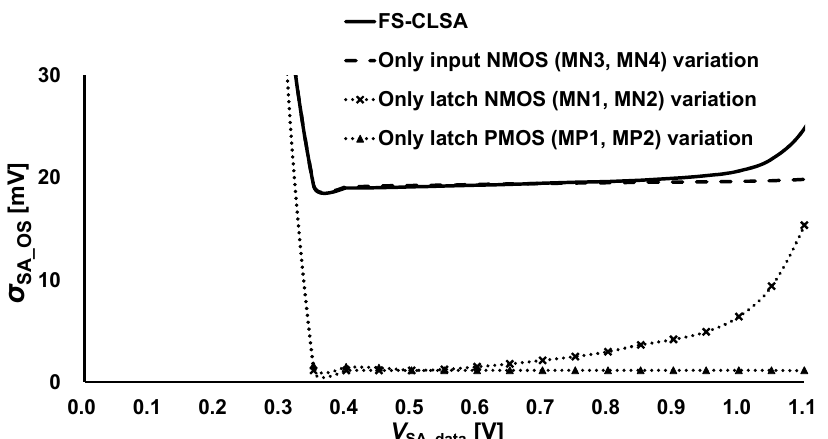
Figure 7. σ SA_OS of the FS-CLSA according to the SA input voltage ( V SA_data ) when the process variation is applied only to the input NMOSs (MN3 and MN4), only to the latch NMOSs (MN1 and MN2), only to the latch PMOSs (MP1 and MP2), and to all transistors.